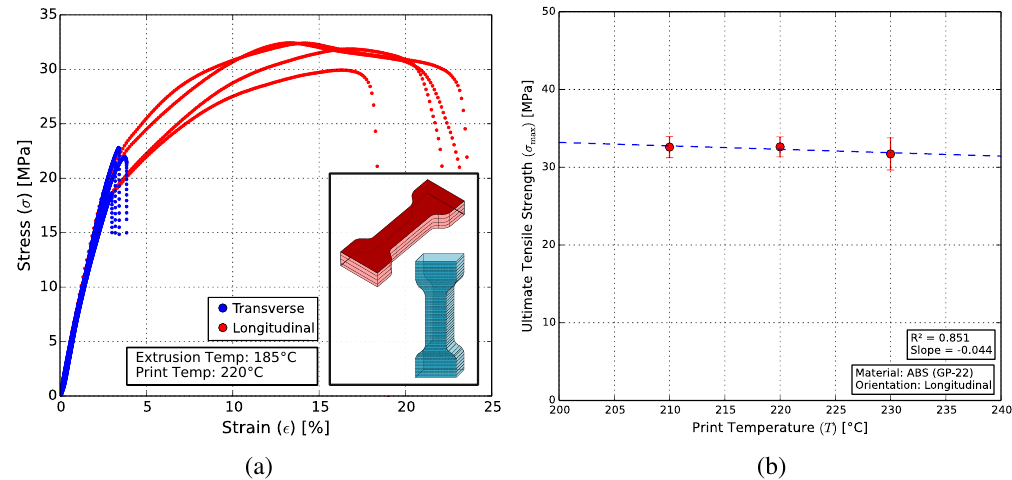
Figure 9. ( a ) The influence of print orientation on the mechanical strength of a tensile test specimen. Longitudinally-oriented samples (red) showed a relatively large region of plastic deformation. Transversely-printed structures (blue), on the other hand, failed at much lower forces without a plastic deformation region. Inset: Illustrations of the print layers for the two print orientations. ( b ) The influence of print temperature on the ultimate tensile strength (UTS) of the tensile specimens is